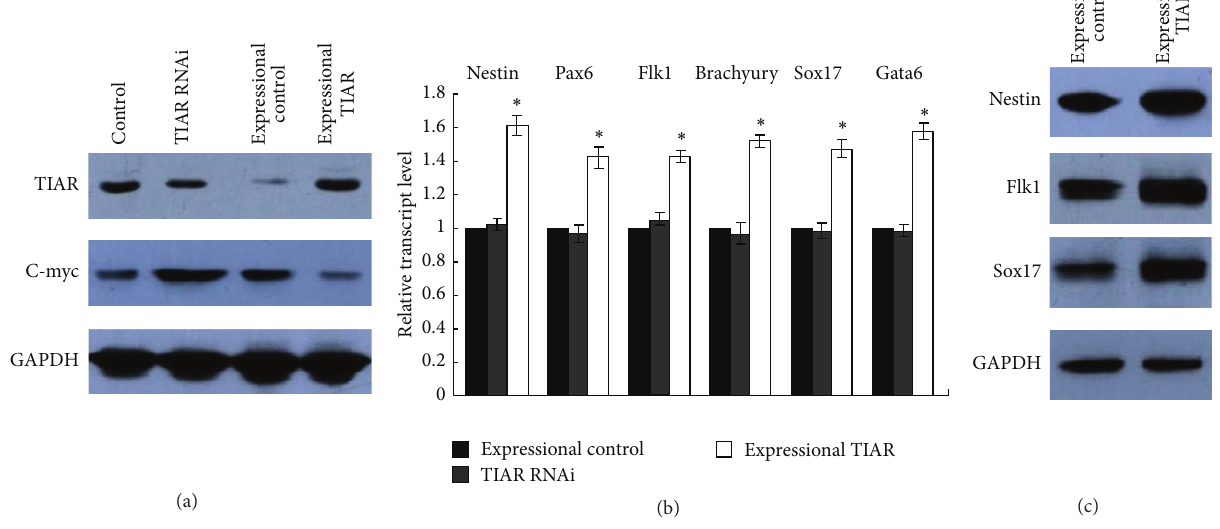
Figure 4: Expression of exogenous RNAi-resistant TIAR rescues the function of TIAR in siRNA-treated cells. (a) Western blot analysis of the expression of TIAR and c-myc in control, TIAR RNAi, expressional control, and expressional TIAR. (b) Quantitative RT-PCR analysis of the gene expression of nestin, Pax6, Flk-1, brachyury, Sox17, and Gata6 on day 4 during EB differentiation in TIAR RNAi, expressional control, and expressional TIAR. (c) Western blot analysis of the gene expression of nestin, Flk-1, and Sox17 on day 4 during EB differentiation in expressional control and expressional TIAR. ∗ 𝑃 < 0.05 by one-way ANOVA. Control: E14 cells infected with an empty control pCDNA3.1- Hygro vector; TIAR RNAi: TIAR RNAi E14 cells; expressional control: TIAR RNAi E14 cells infected with an empty control pCDNA3.1-Hygro